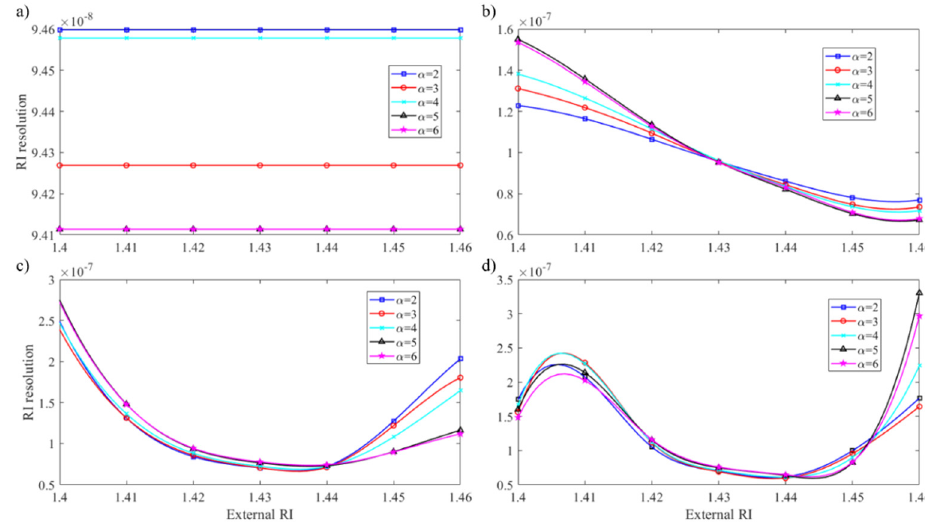
Figure 14. RI resolution for ( a ) linear, ( b ) quadratic, ( c ) cubic and ( d ) quartic fitting functions with different α along the 1.40–1.46 RI range.